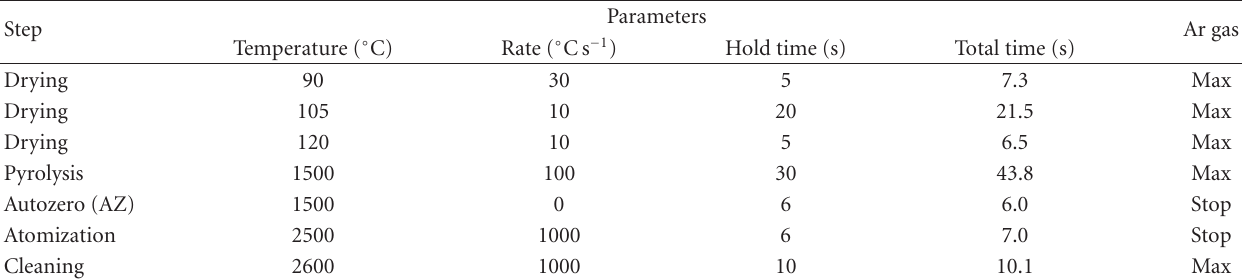
Table 4: Optimized furnace program for the analysis of raw coal (liquid sampling